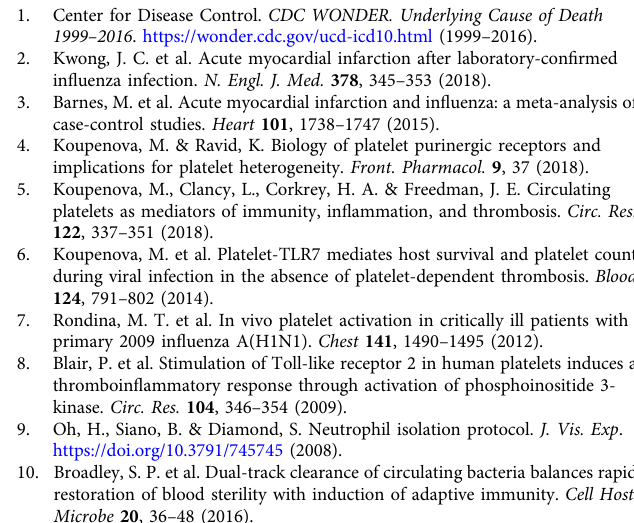
Calculation of in fl uenza virus copy number . Copy number was calculated based on previously published methods 64,65 , and using linearized in fl uenza plasmid DNA (PR8) used to generate a standard curve to calculate viral copy number by qPCR. Detection of free DNA . Detection of DNA in 2 μ L of citrated plasma samples was performed using the Quant-iT ™ PicoGreen ® dsDNA reagent kit and Lambda DNA standard (Invitrogen, CA, USA, cat# P7589) according to the manufacturer ’ s instructions. Brie fl y, 98 μ L of TE buffer were aliquoted in 96-well plate, 2 μ L of plasma were added followed by 100 μ L of PicoGreen ® dsDNA reagent. Fluores- cence was measured on a POLARstar Omega microplate reader (BMG Labtech, Germany) at an excitation wavelength of 480nm and an emission wavelength of 520 nm. Plasma DNA concentration was determined by plotting fl uorescence on the Lambda DNA standard